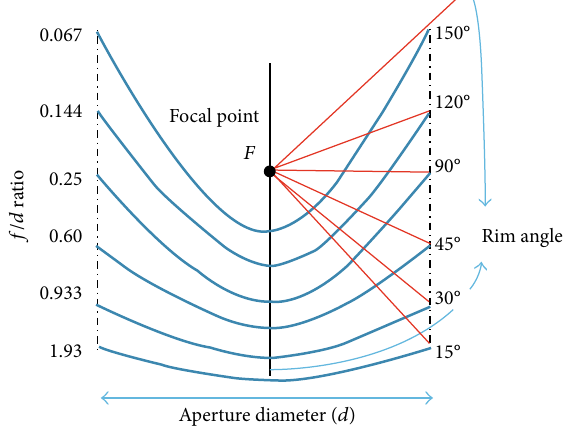
Figure 2: A segment of a parabola having a common focus point and rim angle with the same aperture diameter.